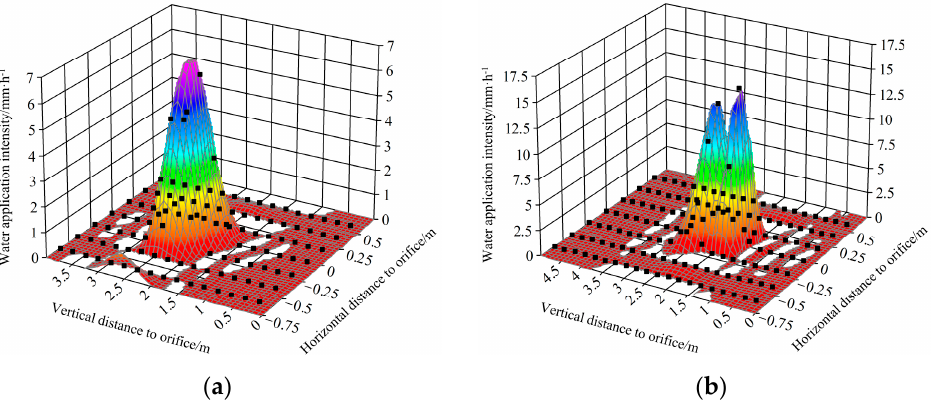
Figure 4. The water application intensity distribution of different individual orifices: ( a ) the individual orifice a 3-5 and ( b ) the individual orifice a 3-1 at 41 kPa, spraying angles of which were 47.8° and 40.7°.